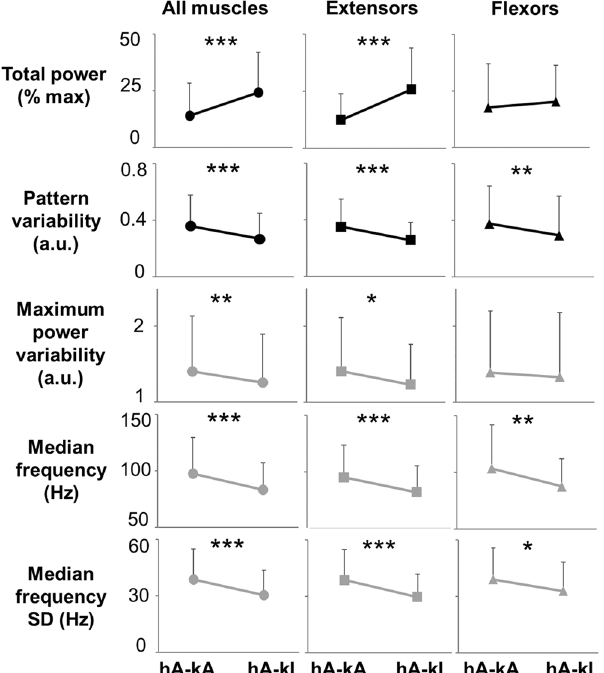
Figure 5. Quantification of EMG time- and frequency-domain features collected during standing with knees assisted or standing with independent knees extension. Representative time- and frequency-domain EMG features collected during standing with external assistance for hips and knees extension (hA-kA), and during standing with hips assisted and independent knees extension (hA-kI). EMG features values were averaged among research participants (n = 8) and among all investigated muscles (left and right soleus, medial gastrocnemius, vastus lateralis, rectus femoris, gluteus maximus, tibialis anterior and medial hamstring; total n = 114), among primary extensor muscles (left and right soleus, medial gastrocnemius, vastus lateralis, rectus femoris, gluteus maximus; total n = 80), or among primary flexor muscles (left and right tibialis anterior and medial hamstring; total n = 32). Values are expressed as mean ± standard deviation (SD). Differences were tested by Wilcoxon test. * p < 0.05; ** p < 0.01; *** p <